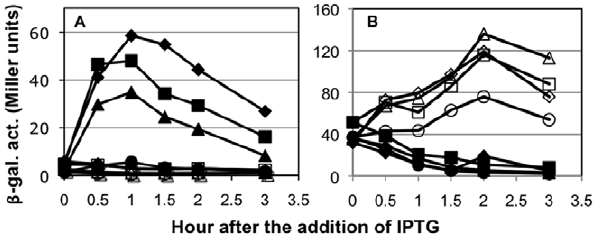
Figure 3. Effect of amino acid substitutions within and near helix a 4 of Spx on the transcription of trxB (A) and srfA (B) . Strains carrying trxB-lacZ (A) or srfA-lacZ (B) were grown in DS medium. When the OD 600 was 0.4 to 0.5, each culture was divided into two flasks, and 1 mM IPTG was added to one flask to induce Spx DD . Samples were taken at time intervals and b -galactosidase activities were measured. (A) Symbols: squares, ORB6894 with Spx DD ; circles, ORB6895 with Spx DD-R60E ; triangles, ORB6896 with Spx DD-K62E ; diamonds, ORB 6897 with Spx DD-K66E . (B) Symbols: squares, ORB6129 with Spx DD ; circles, ORB6934 with Spx DD-R60E ; triangles, ORB6935 with Spx DD-K62E ; diamonds, ORB6936 with Spx DD-K66E . Open symbols represent cells cultured without IPTG and closed symbols represent cells cultured with IPTG.